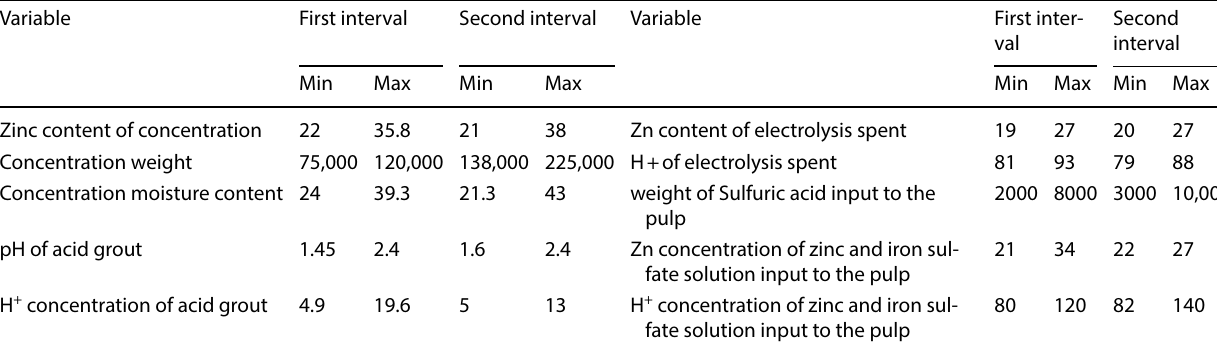
Table 17 Tolerance of the input